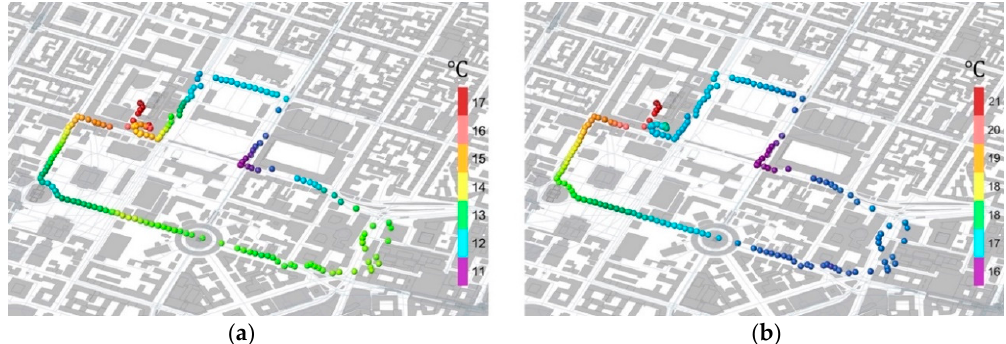
Figure 25. ( a ) Elevation of the path (m); ( b ) walking ground speed (km/h).